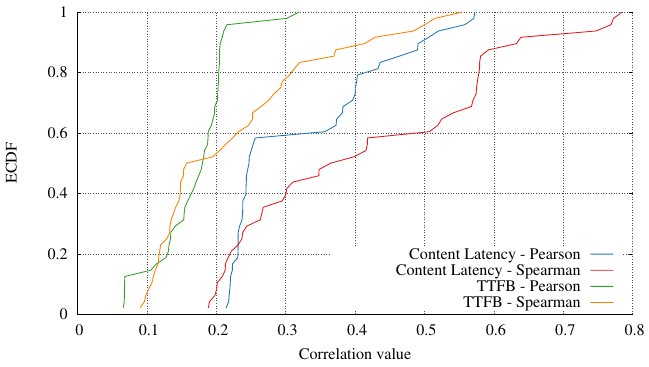
Figure 2. Correlation for Content Latency and TTFB.